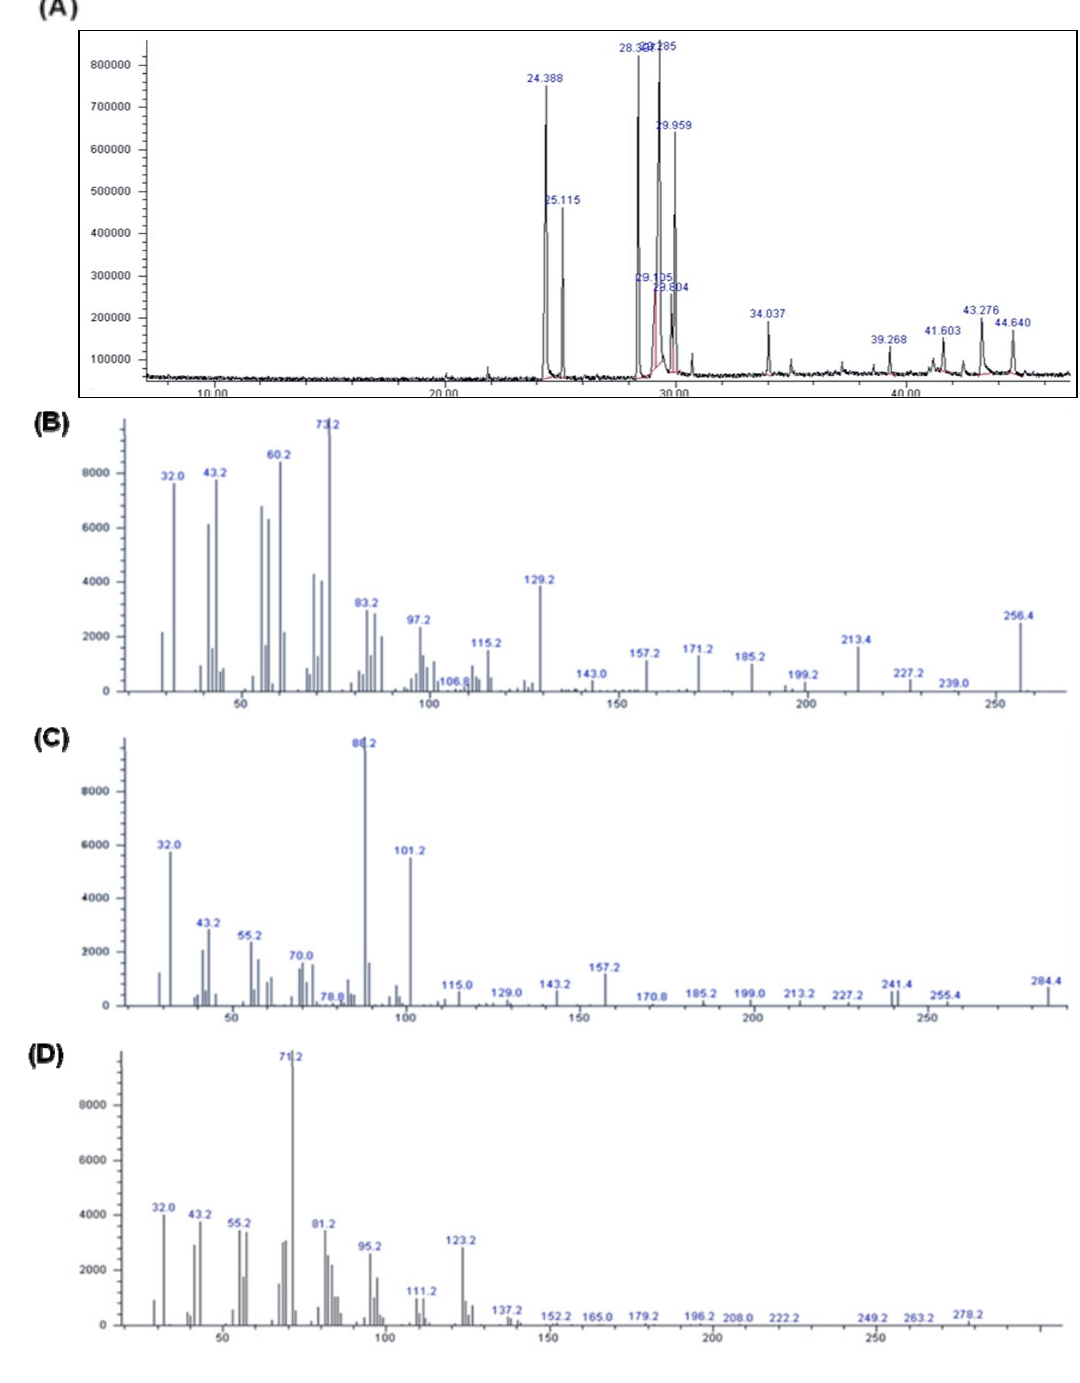
Figure 6. Gas chromatogram and MS Spectra of hexane fractions from Prunella vulgaris var. lilacina . ( A ) Gas chromatogram of hexane fractions from Prunella vulgaris var. lilacina